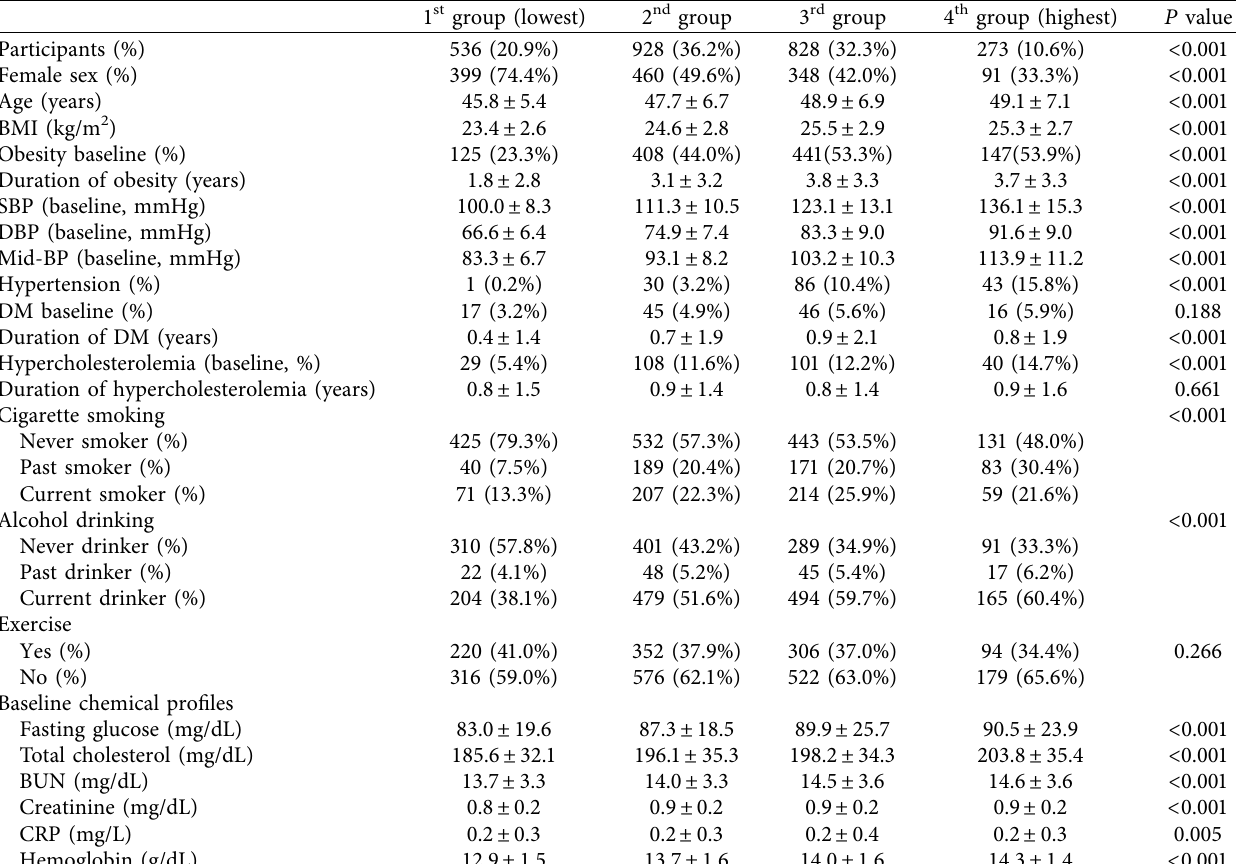
Table 1: Participants’ characteristics according to mid-BP trajectory groups (trajectory groups defined by total).